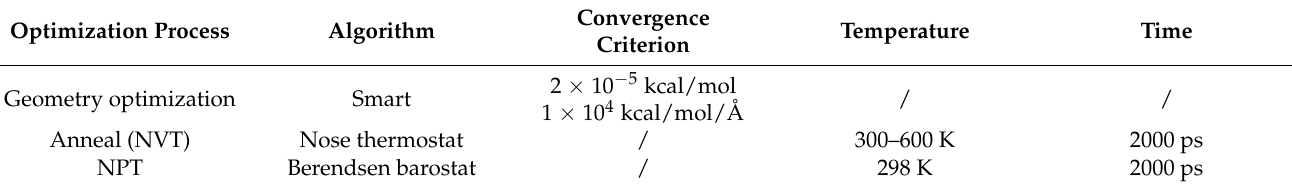
Table 1. Parameters of optimizations.